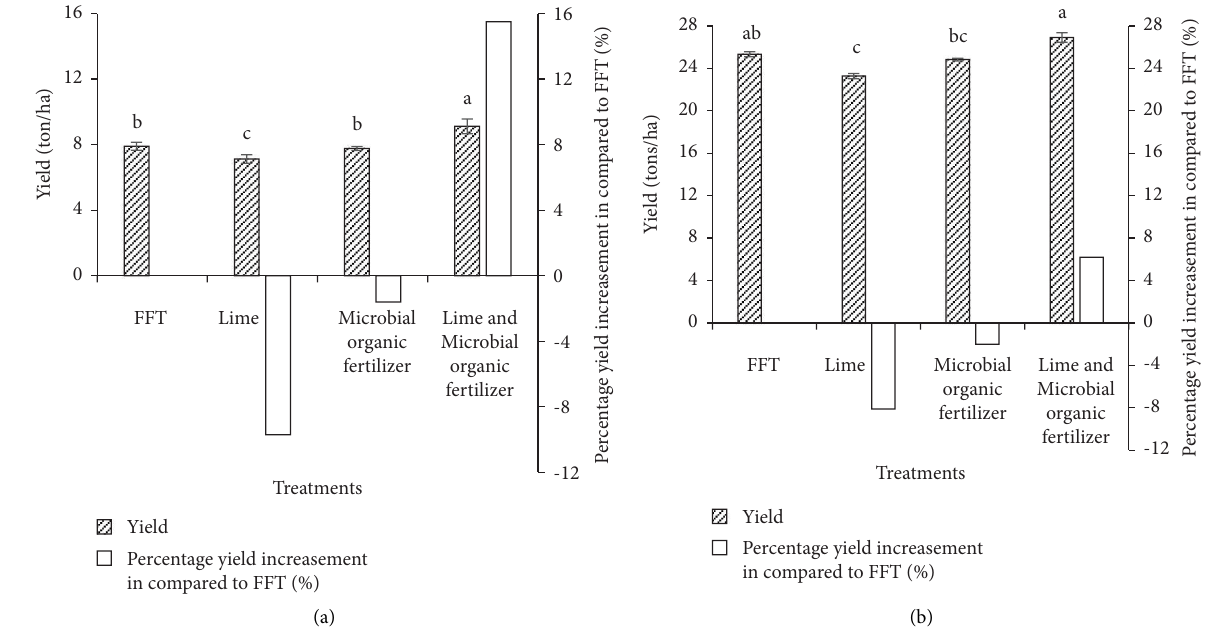
Figure 5: Yield and percentage yield increment compared to FFT in the experimental treatments: (a) glutinous corn and (b) watermelon.